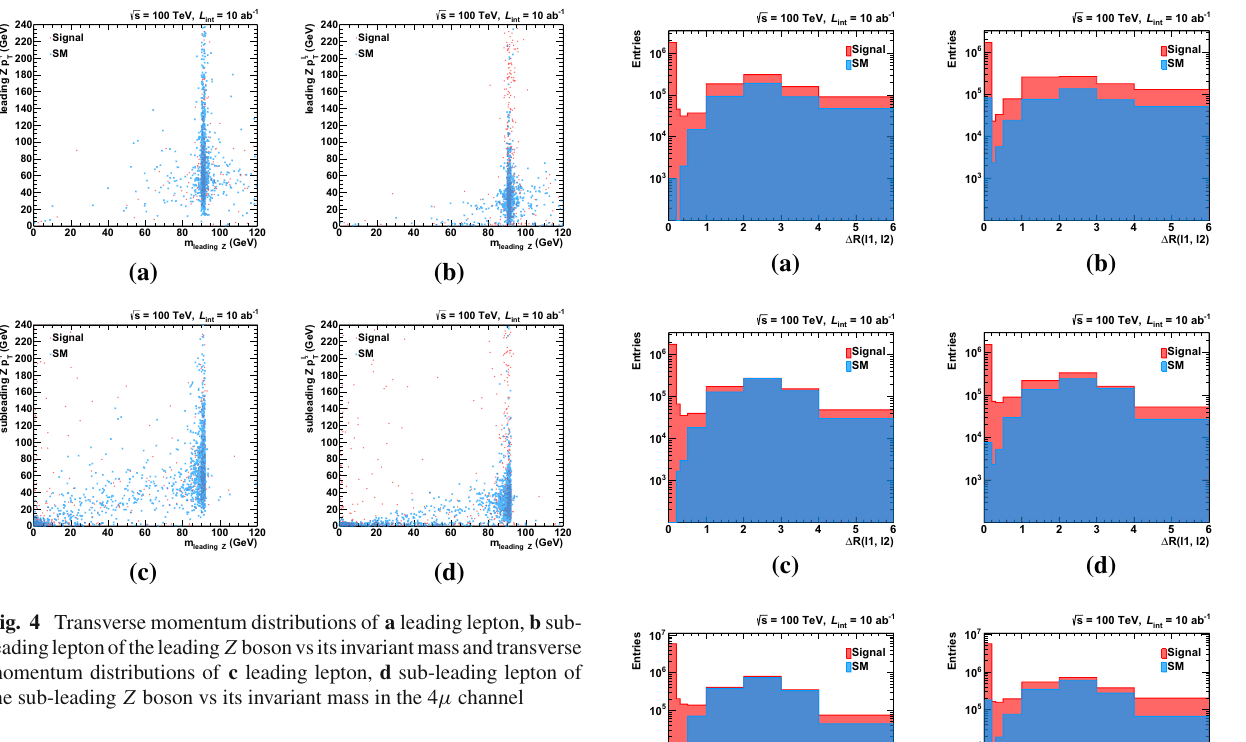
The pseudo-rapidity cuts of all leptons are applied as | η (cid:2) | < 2.5. The distance (cid:13) R ((cid:2) 1 , (cid:2) 2 ) between leptons in the η – φ plane is evaluated by the function